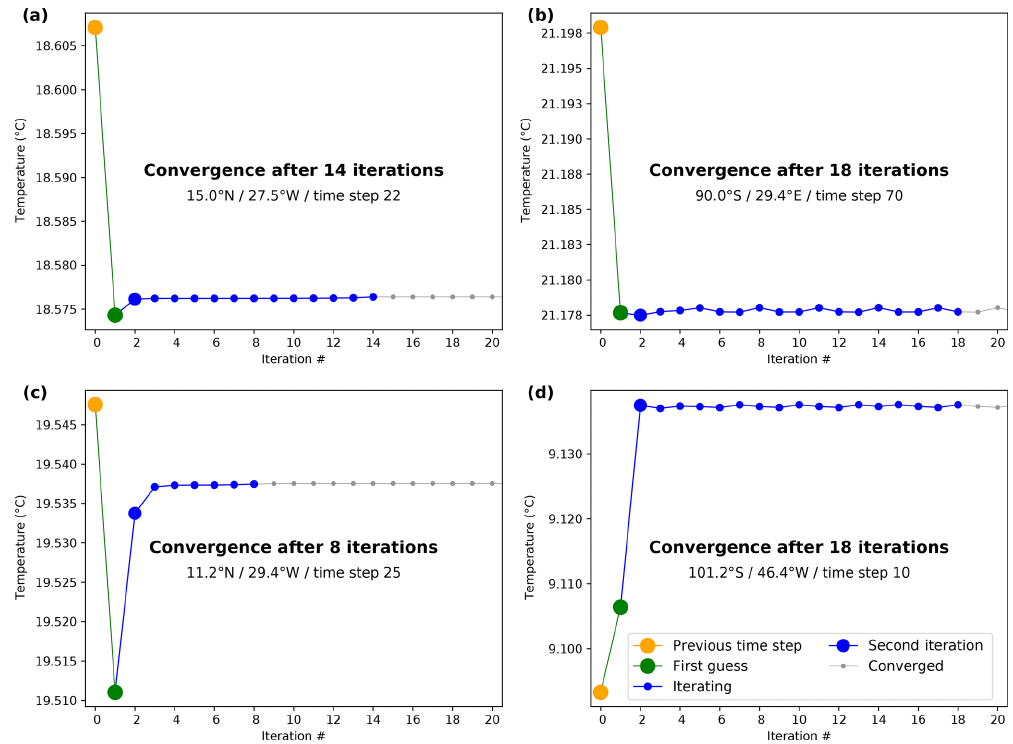
Figure 3. Behavior of the sea surface temperature in four selected cases (i.e., instances of the Schwarz algorithm in space × time) for the parallel algorithm. For each graph, the yellow dots show the values at the end of the previous Schwarz window, when Schwarz has converged. This is the initial state of the present window. The green dots show the values after the first iteration. It is the value that the models use with the legacy parallel algorithm not iterated. The blue dots show the iterative process. Dots become grey when T (cid:127) is considered to be converged. The two top cases (a, b) come from the (cid:49)t = 4h experiment. The bottom cases (c, d) come from the (cid:49)t = 1h